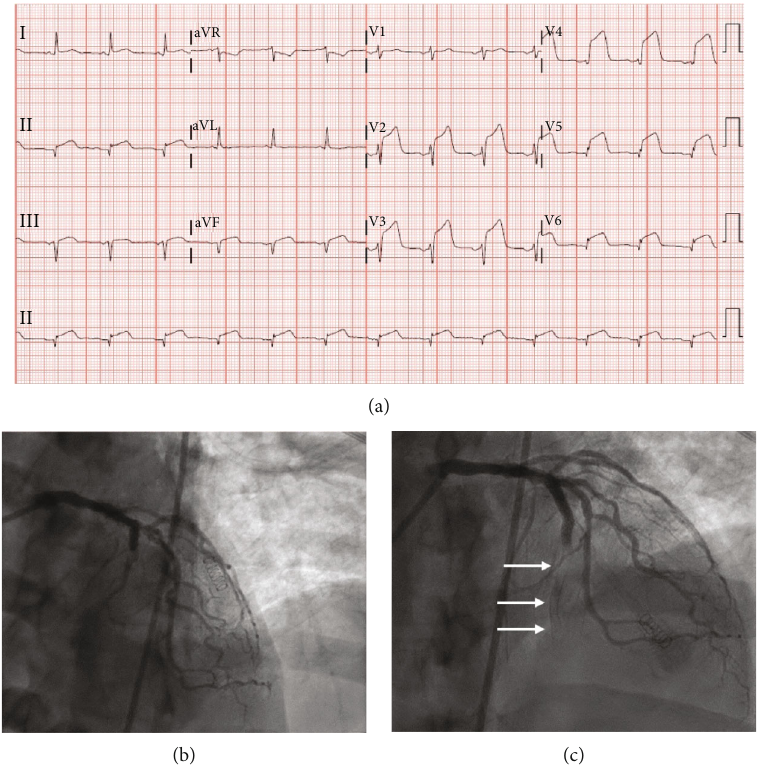
Figure 1: ECG on admission and LHC fi ndings. (a) ECG showing ST elevations in anterior leads. (b) Initial coronary angiography. (c) Coronary angiography after PCI. Arrows indicate the course of